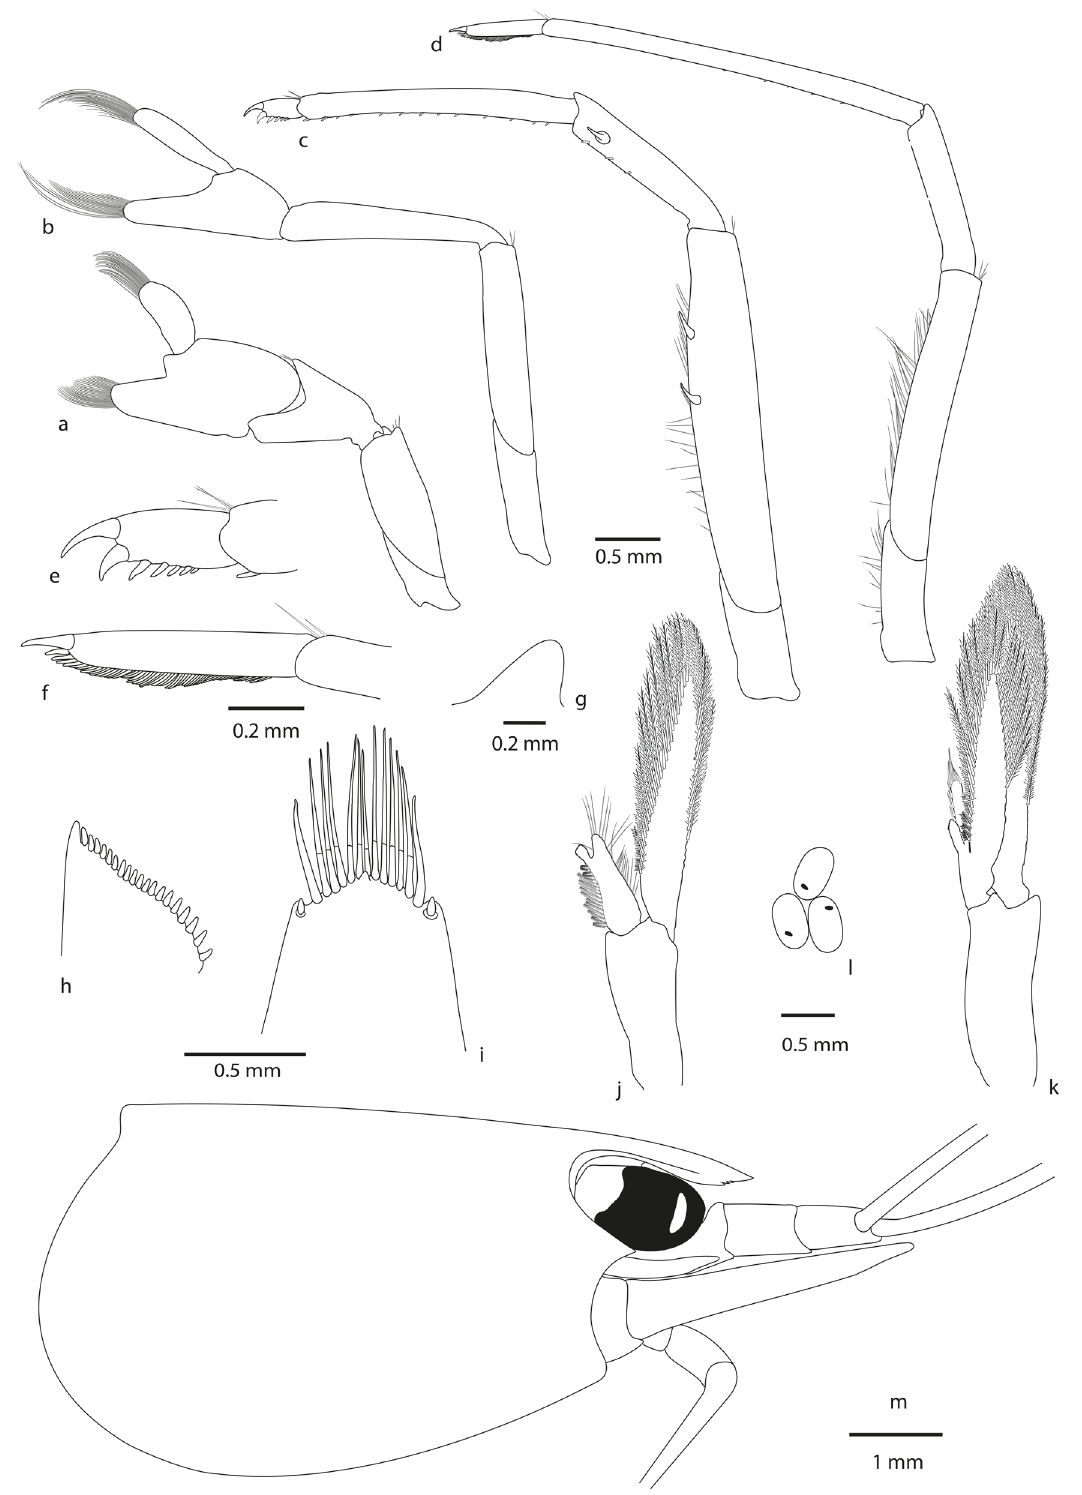
Fig. 22. Caridina paratypus sp. nov. a . First pereiopod. b . Second pereiopod. c . Third pereiopod. d . Fifth pereiopod. e . Dactylus of third pereiopod. f . Dactylus of fifth pereiopod. g . Pre-anal carina. h .